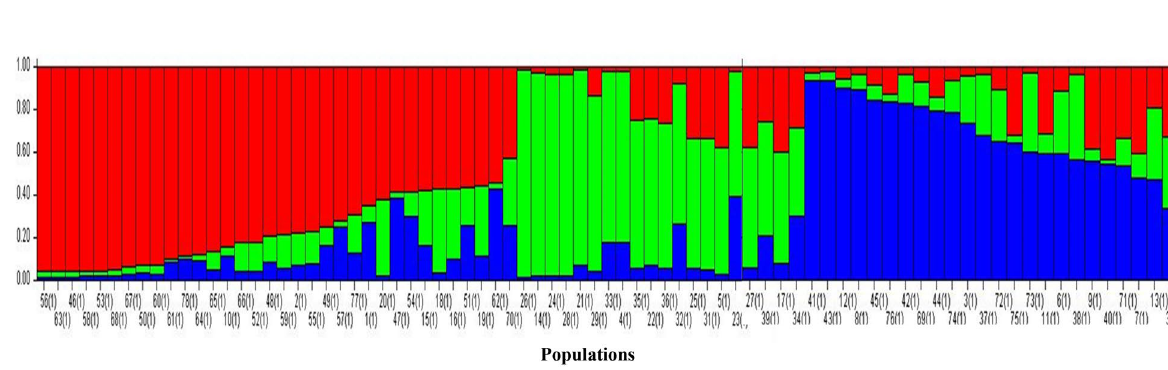
Figure 2. Estimated genetic structure at K = 3 for the 78 Bambara groundnut landraces using the admixture model of population structure. Population 1 is indicated in red, population 2 in green and population 3 in with one of the landraces from Zimbabwe. Furthermore, the genetic variation between landraces varied between 87% similarity between a landrace from the South African germplasm collection (SA_7) and a landrace from Swaziland (SWAZ 4). In this case however, both accessions had dark brown seeds. Cluster III is the cluster with the lowest number of landraces (8). These included landraces from SA, Botswana, Namibia and two landraces from unknown origin (ND). This small cluster was divided into two sub-clusters. Seed colour for this cluster indicated to be predominantly light brown (38%), followed by equal contributions to cream white (25%) and black (25%) and only 12% dark brown seeds. The landrace from unknown origin (ND_1) in sub-cluster 1 of cluster III showed significant genetic similarity as but differed in seed colour with landraces from Namibia and Botswana. This also describes the relationship of a landrace from unknown origin (ND_4) in sub-cluster 2, with landraces from SA and Botswana. No clones (100% similarity) were observed in any of the main clusters. Bayesian model‑based clustering. Structure analysis delineates clusters of individuals based on their genotype by using Bayesian model-based clustering. This analysis is done without prior knowledge of the genotypes. The optimum number of genetic clusters for the 78 landraces was determined at K = 3 as identified by Evanno et al.’s 34 ad hoc ΔK method. The 78 landraces divided into three populations ( K = 3) (Fig. 2), which is the minimum observed number of populations using this protocol. Thus all of the landraces could have been part of a single population. Structure analysis with three populations K = 3 (Fig. 2) identified three clusters—Population 1 (red) composed of landraces from SA, Botswana, Namibia, Swaziland and some of unknown origin. Population 2 (green) containing the bulk of the landraces from South Africa with a mixture of landraces from six of the other origins and one land race from the unknown origin, Population 3 (blue) contained most of the landraces from Botswana. These results confirmed the genotypic diversity observed within the landraces using cluster analysis. Population 1 consisted mainly of the genetic contribution of Swaziland landraces (60%) and landraces of unknown origin (57%) (Table 5). A moderate percentage of the genetic contribution of landraces from Botswana,